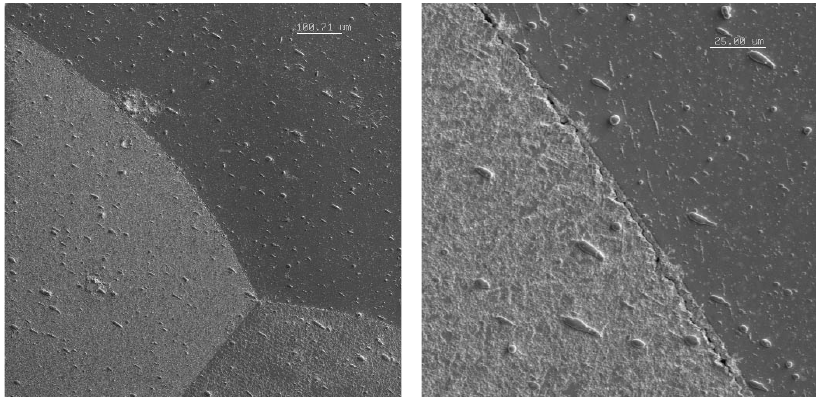
FIG. 27. Grain-boundary cracks in the area of maximum temperature rise. The grain boundary is the transition where the whitening due to slip bands stops. A close-up of one crack is on the right where the grain boundary is clear. The length scales are 100 : 7 (cid:3) m and 25 : 0 (cid:3) m ,